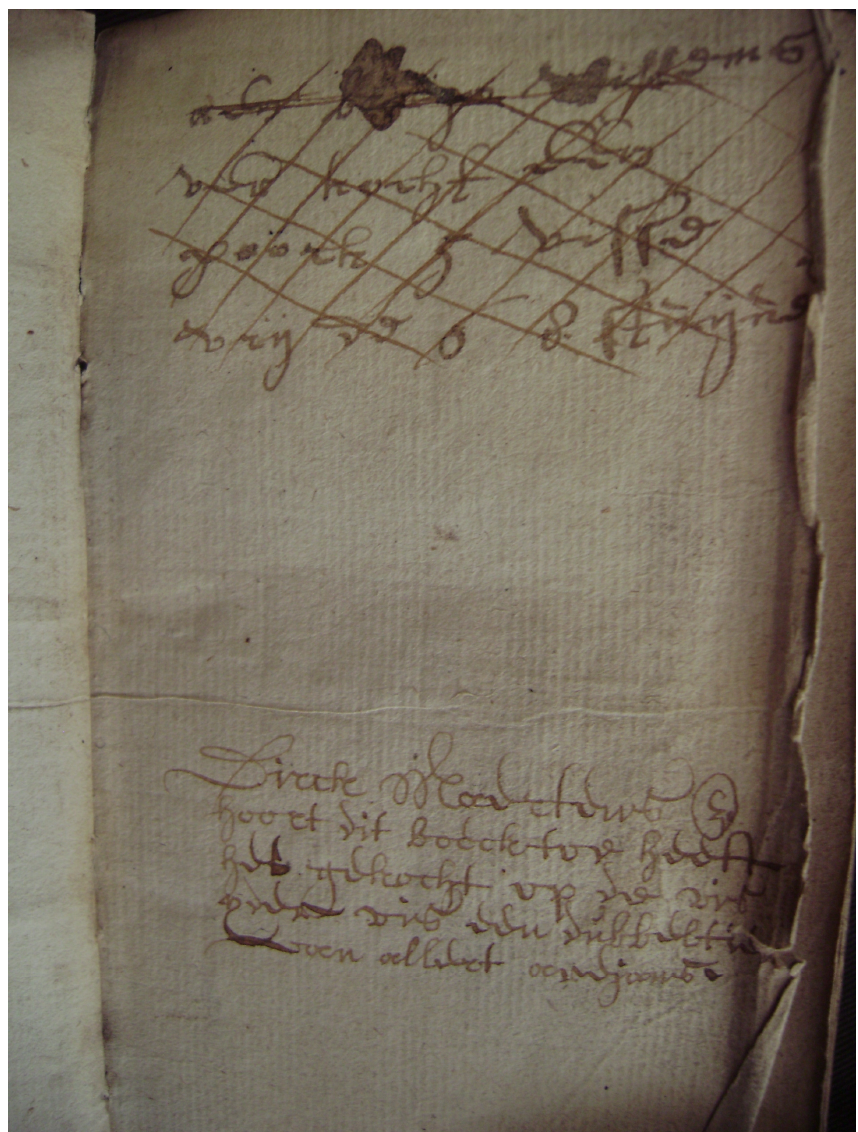
Figure 3. Reminder of a sale of fish on the next empty page of the same book, and new owner’s inscription.